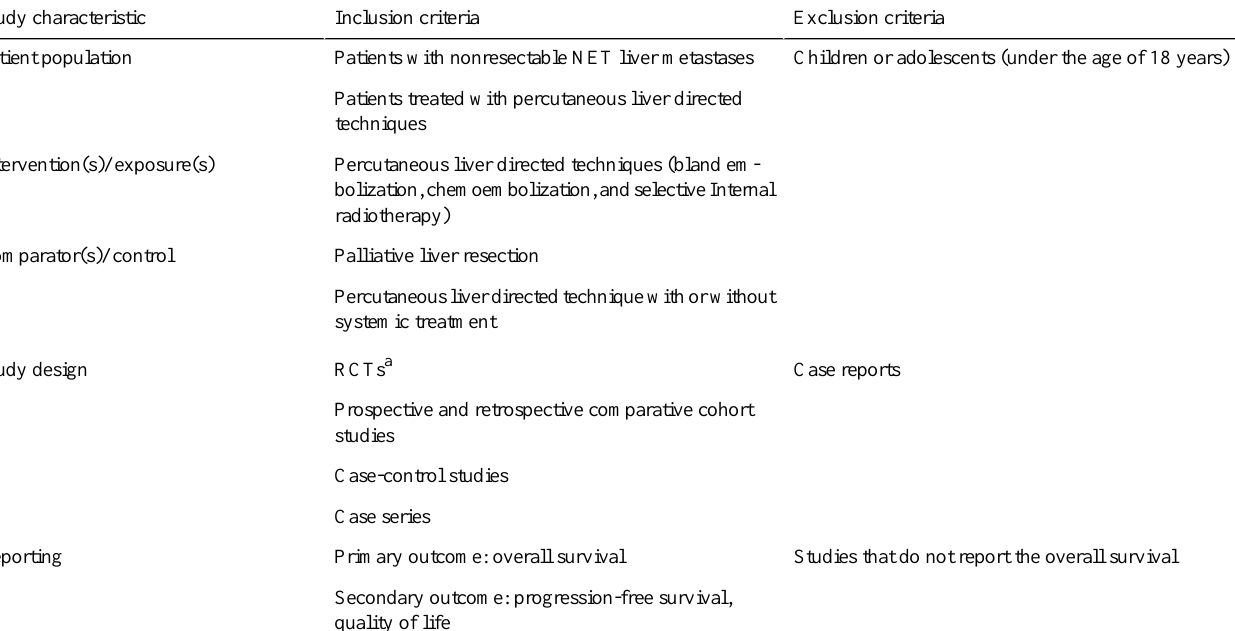
Table 2. Eligibility criteria for review 2: when should percutaneous liver-directed techniques be used in patients with nonresectable neuroendocrine liver